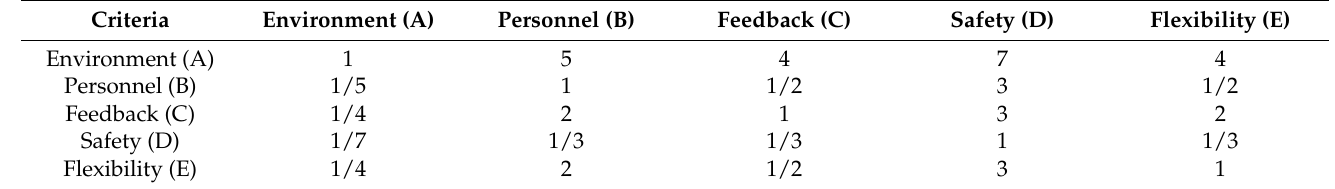
Table 4. The de-fuzzified pairwise comparison matrix for five main criteria from FANP model.